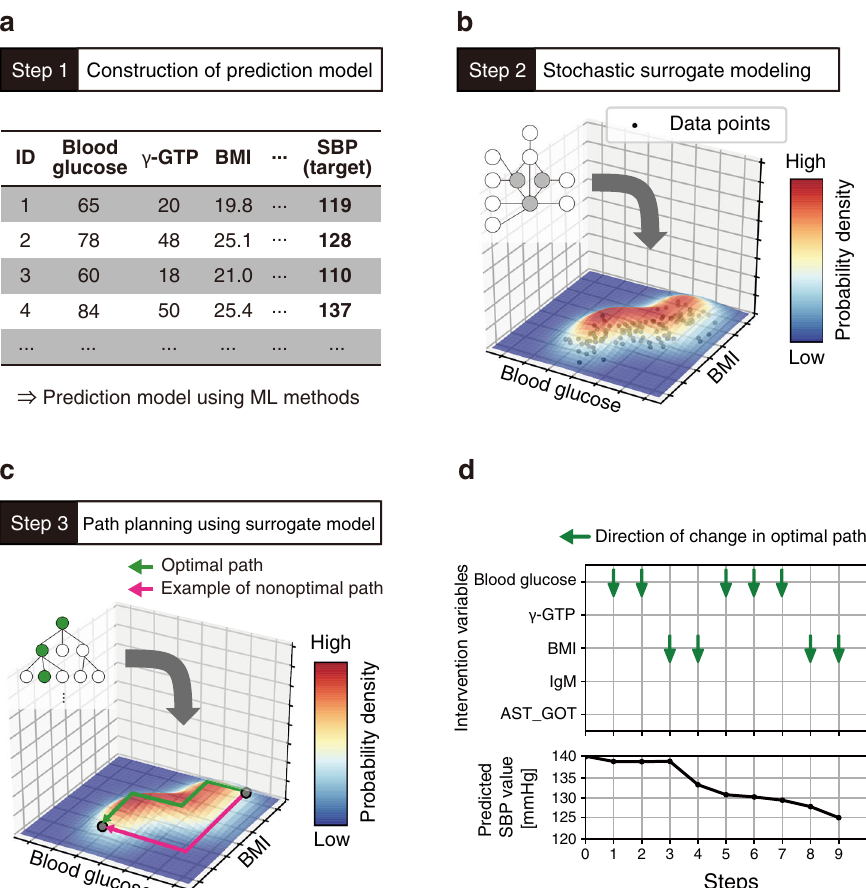
Fig. 1 Schematic representation of the framework for planning actionable paths for treatment using hierarchical Bayesian modeling. The framework consists of three steps. A schematic is given as an example in which a path is planned to improve the systolic blood pressure (SBP) owing to changes in blood data and body composition data. a Construction of a prediction model from the dataset. A variable SBP is set as the response variable in this case. b Construction of a stochastic surrogate model based on the original dataset and the predicted values of the prediction model. This fi gure shows a schematic representation of a two-variable space regarding blood glucose and body mass index (BMI). The heatmap and vertical axis represent the existence probability of data in the variable space, which is expressed by the stochastic surrogate model. c , d Actionable path planning is applied to improve the response variable. The path is represented as a set of multistep transitions on explanatory variables. In our framework, the optimal path (green line in ( c )) is planned on the grid graph with high probabilities in the variable space based on the stochastic surrogate model. Conversely, the nonoptimal path (red line in ( c )) could pass through nodes with low probability. γ -GTP gamma glutamyl transferase, IgM immunoglobulin M, AST_GOT aspartate